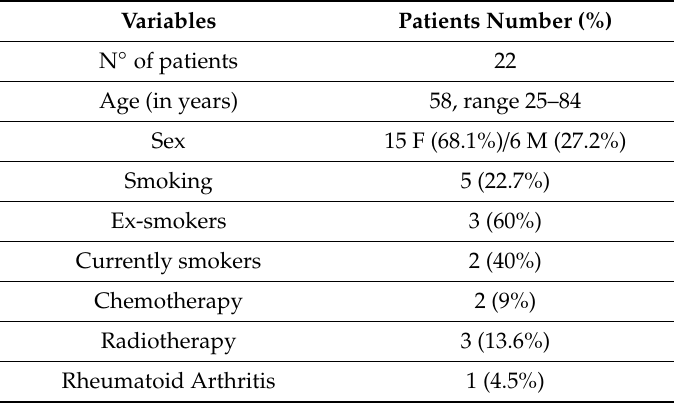
Table 2. Demographic data of our population study.